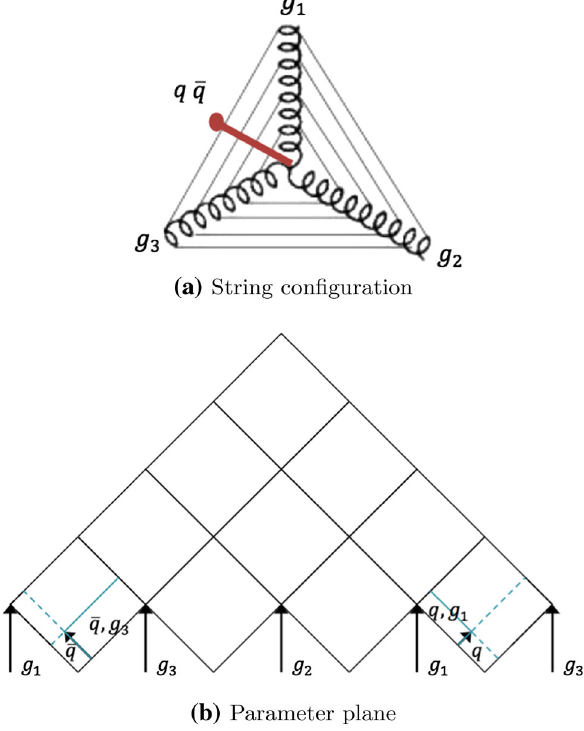
Fig. 12 The string configuration and the corresponding parameter planeforathreegluon-looptopology.Inthetwoinitialendpointregions the full lines indicate the “active area”, and the dashed ones the com- plementary excluded